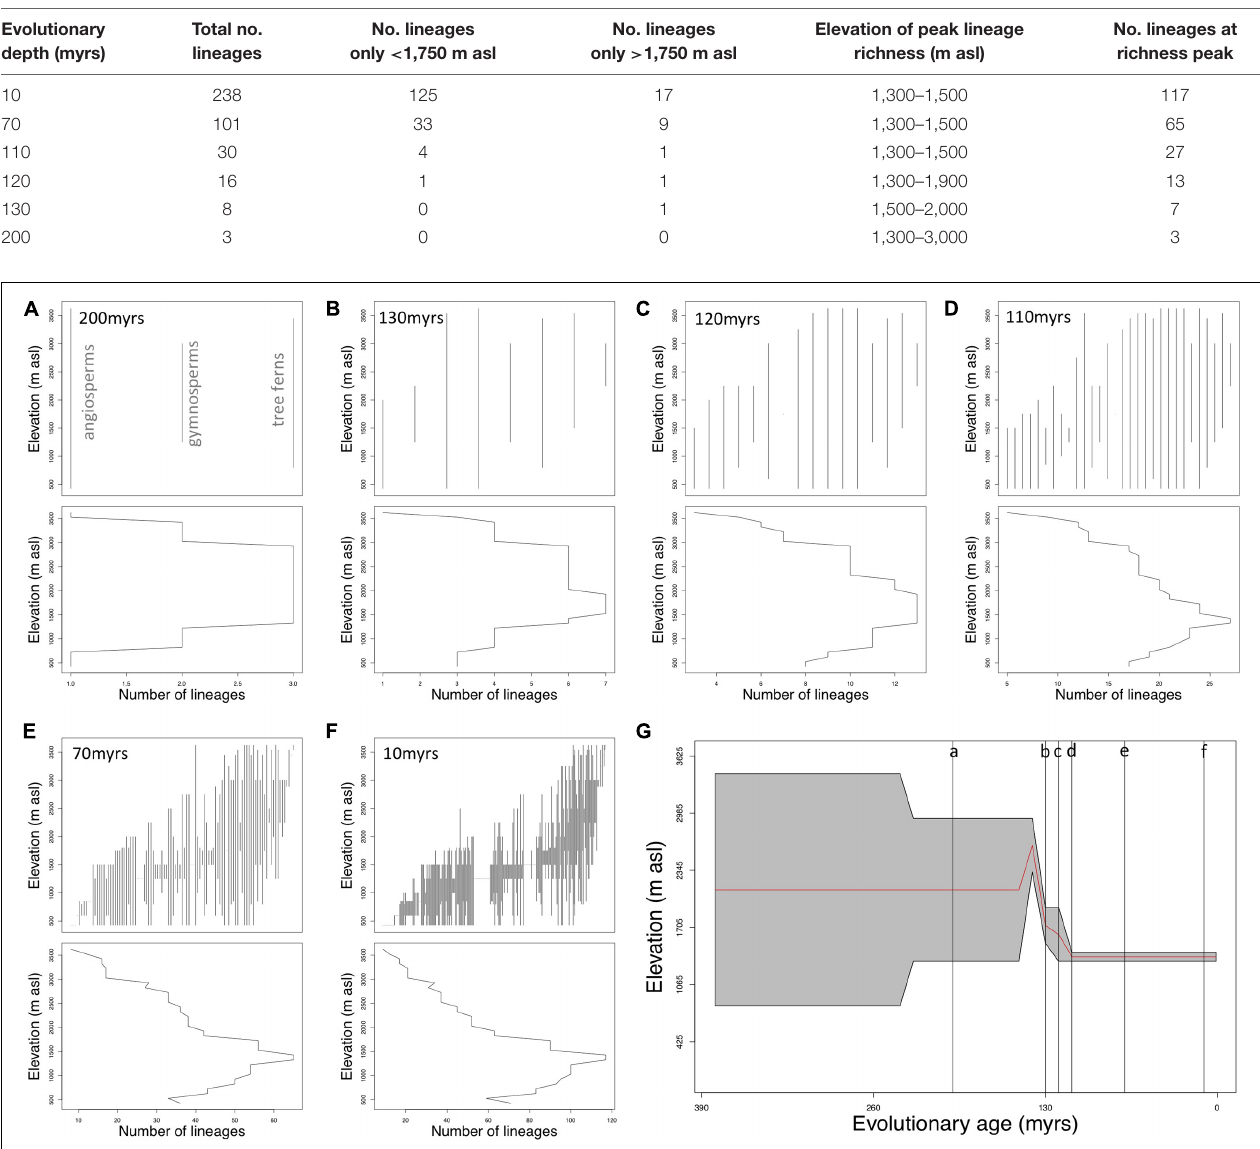
FIGURE 3 | ( A–F) Illustrate how evolutionary age structure varies across elevation and at six notable evolutionary depths (A) 200 myrs, (B) 130 myrs, (C) 120 myrs, (D) 110 myrs, (E) 70 myrs, and (F) 10 myrs. Within each panel, the upper plot illustrates the elevational ranges of lineages. Vertical lines represent each individual lineage present at the respective evolutionary depth. Lower plots represent the number of lineages (x-axis) across elevation (y-axis) at each of the size evolutionary depths. (G) Illustrates how the elevations at which lineage richness is most numerous changes across different evolutionary depths. The gray shaded area represents the elevations most numerous in lineages across evolutionary depths. The red line illustrates mean elevation of the peak number of lineages. Vertical gray lines in (G) with letters relate to (A–F)